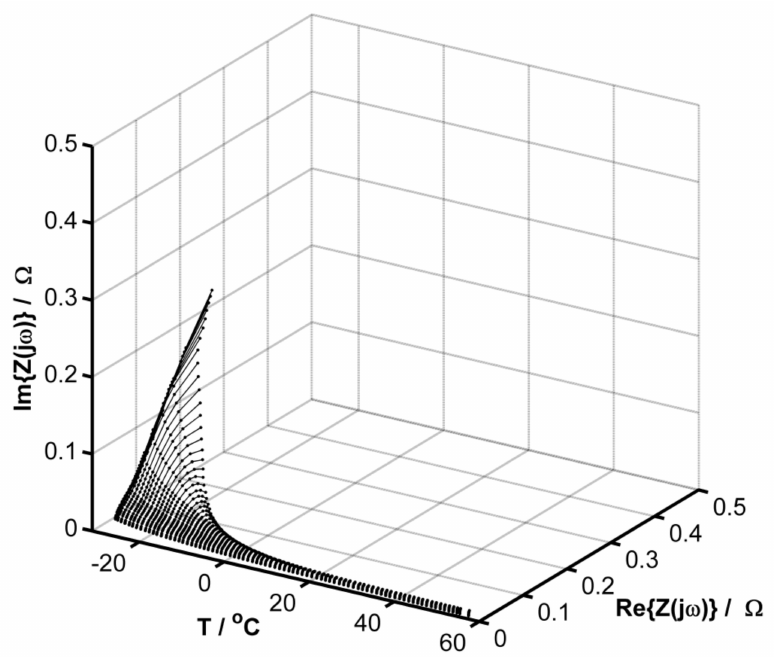
Figure 3. Impedance graph recorded for the tested LiC during dynamic temperature change in the range from − 30 to 60 degrees Celsius in the galvanostatic mode for SoC = 100% (3.8 V). For comparison, two impedance graphs as a function of temperature for SoC = 0% and SoC = 100% are shown on one graph. The comparison of two impedance graphs confirms the predominant influence of temperature on LiC operation in comparison with operating voltage. For a more detailed analysis of the shape of the impedance spectra, the graph is divided into two ranges: from − 30 to 15 degrees Celsius (Figure 4) and from 15 to 60 degrees Celsius (Figure 5). At low temperatures, where the process of